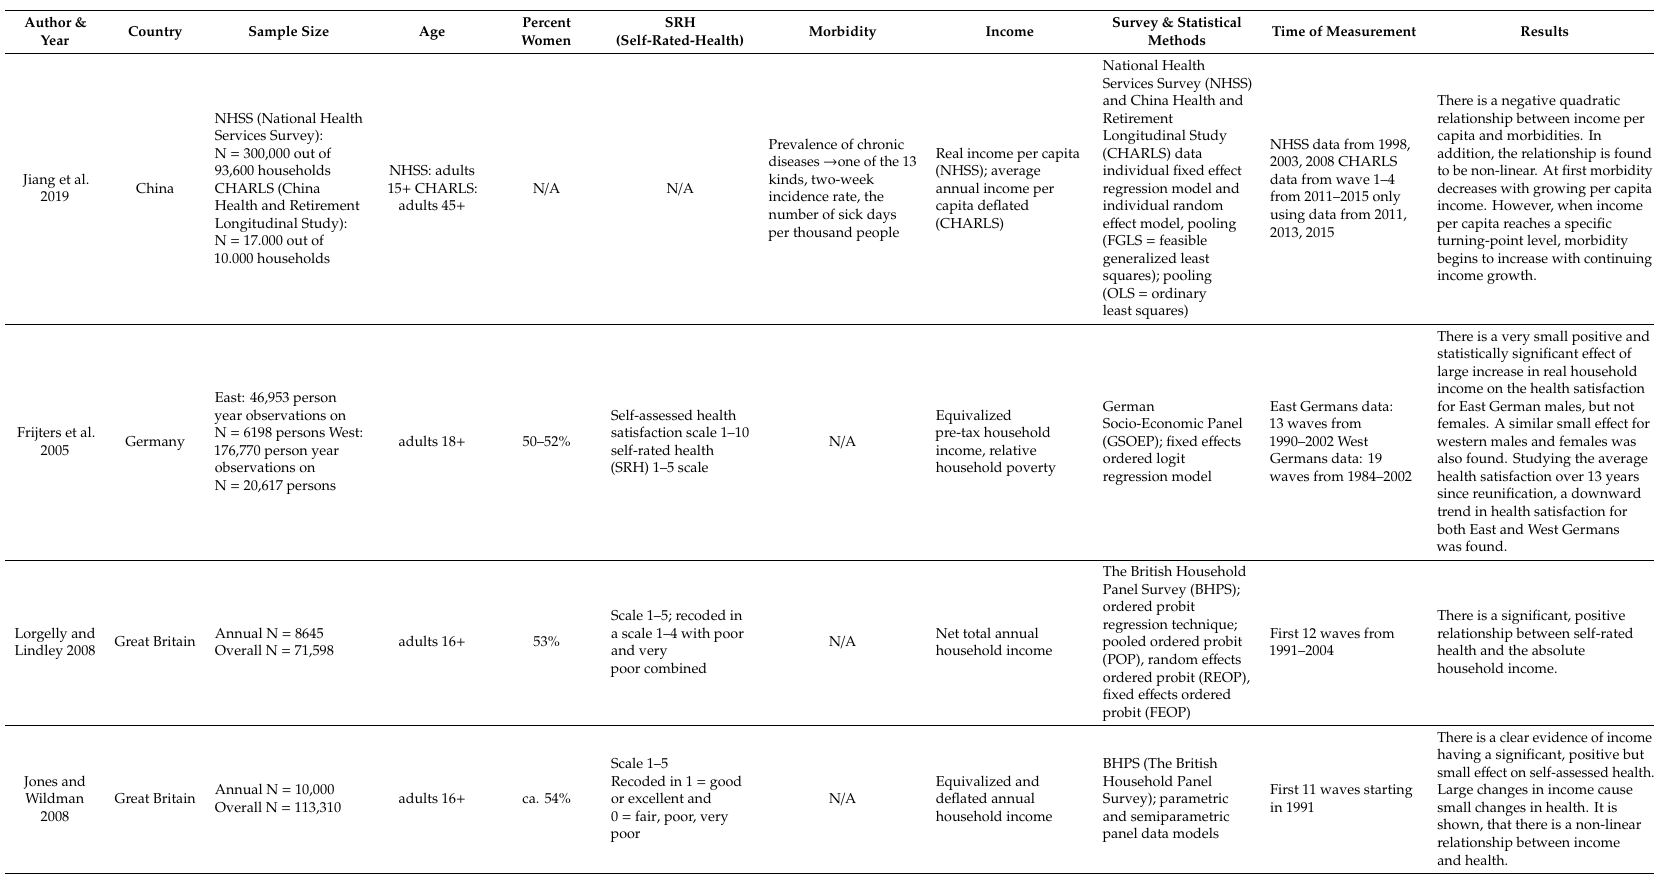
Table 1. Summary of included papers in the